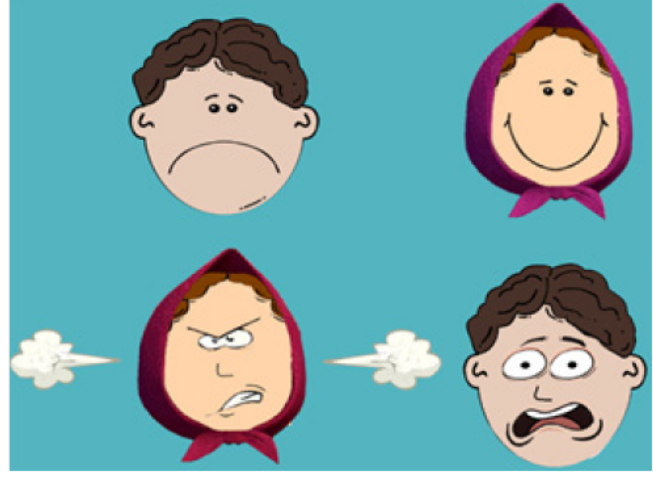
Figure 5. Screenshot of the game “Smile 1,” which was developed to help autistic children recognize different emotions